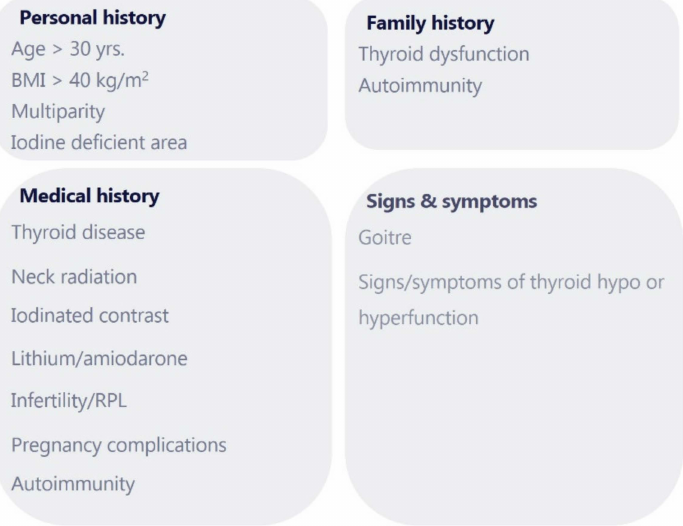
Figure 1. Risk factors for thyroid disease in the preconception period; Yrs—years; BMI—body mass index; RPL—recurrent pregnancy